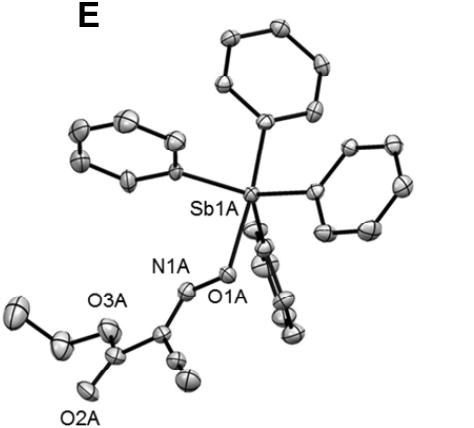
Figure 3. The ASU in the structures of SbPh 4 (2PCO) ( A ), SbPh 4 (3PCO) ( B ), SbPh 4 (4PCO) ( C ), and SbPh 4 (MCO) ( D ); only one of two independent molecules is displayed. SbPh 4 (ECO) ( E ) (only one of two independent molecules present) and SbPh 4 (ACO) ( F ), showing numbering of principal atoms only. Details of the geometry of crystal structures are presented in SI section. H-atoms are omitted for clarity.